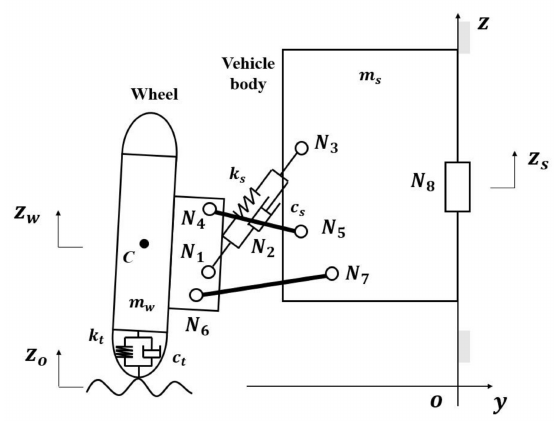
Figure 7. Planar quarter-vehicle dynamic model.